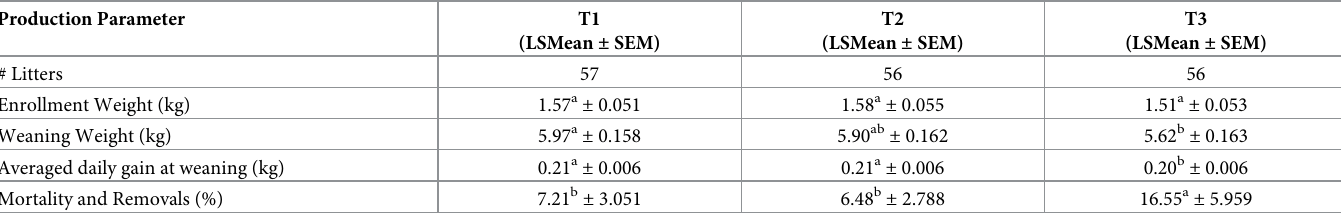
Table 1. Pre-weaning performance comparison in litters raised using a standard (T1), modified antibiotic medication (T2), or ABF production protocol (T3).